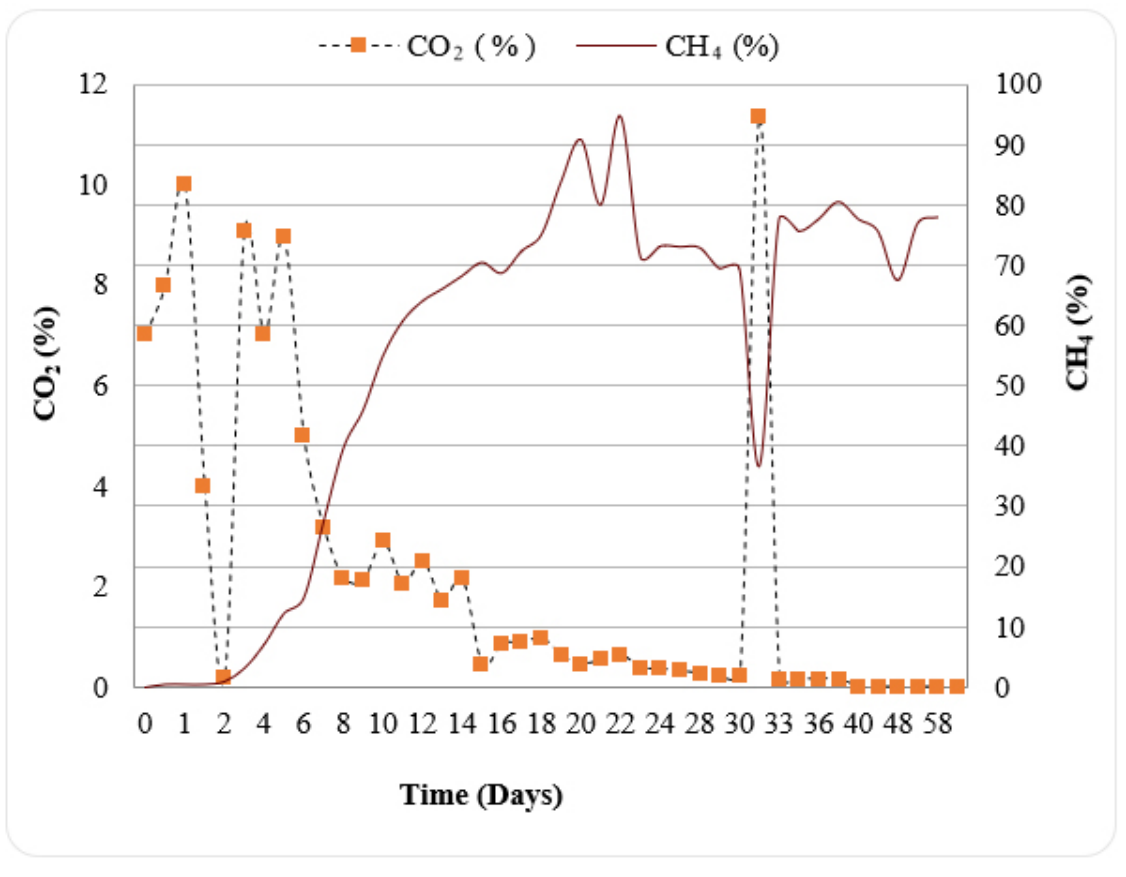
Figure 3. Methane and carbon dioxide composition of daily biogas (scrubbed) production from experiments.